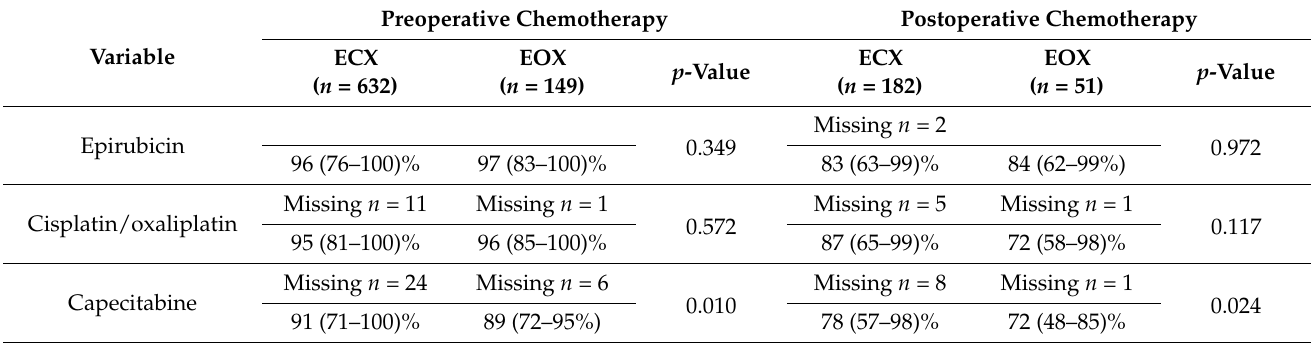
Table 2. Relative dose intensities are displayed as median plus interquartile range.